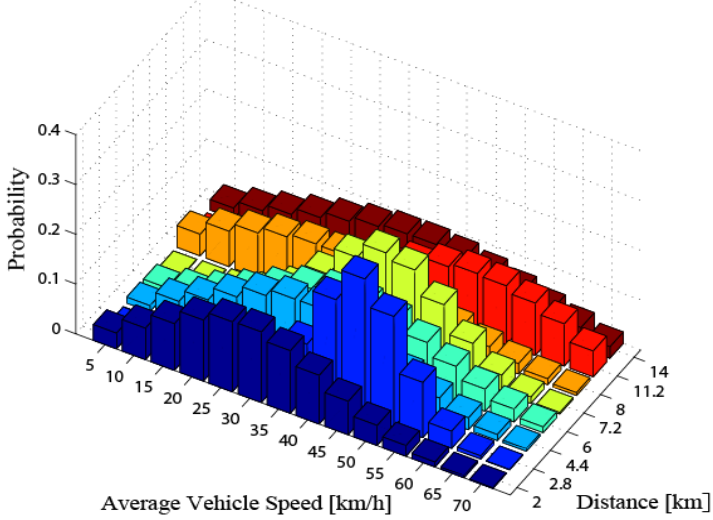
Figure 8. Probability distribution in each segment of the driving